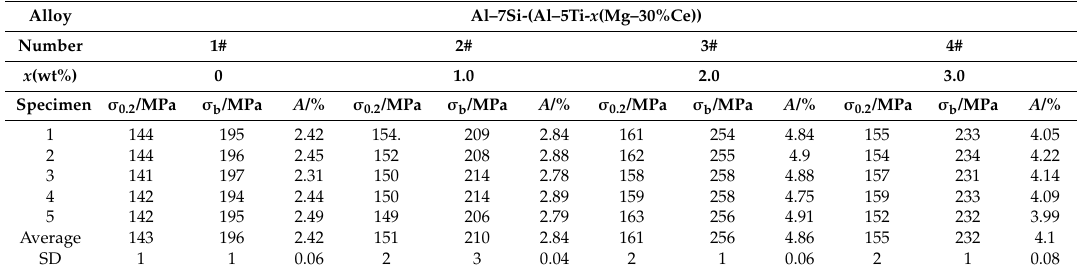
Table 2. The tensile test results of aluminum silicon alloy after